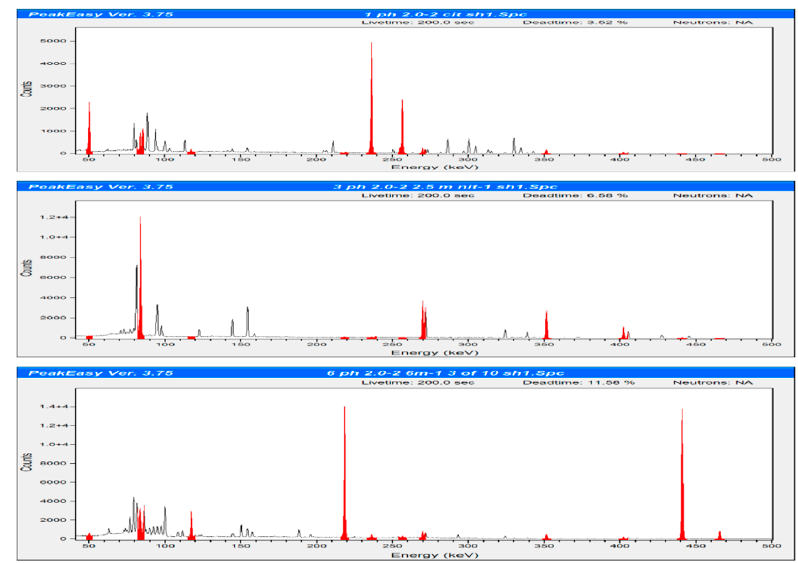
Figure 3. Gamma spectroscopy spectrums of the eluted: load ( top ), 2.5-M nitric acid ( middle ) and 6-M nitric acid ( bottom ) solutions from the cation study with 1 M citric acid at pH 2.0. PeakEasy version 3.75 was used to plot the spectra from 40.9 to 500.5 keV, and the following regions of interest were highlighted: 227 Th and daughters 50 keV ( 227 Th), 83 keV ( 223 Ra), 118 keV ( 209 Tl), 218 keV ( 221 Fr), 236 keV ( 227 Th), 256 keV ( 227 Th), 269 keV ( 223 Ra), 271 ( 229 Rn), 351 keV ( 211 Bi), 402 keV ( 219 Rn), 440 keV ( 213 Bi) and 465 keV ( 209 Tl). Table 1. Percentage of eluted elements in the various steps of the separation using the following rinse sequence: 5 mL of 1 M citric acid pH 2, 3 mL of water, 3 mL of 2 M nitric acid, 2 × 3 mL of 2.5 M nitric acid and 2 × 10 mL of 6 M nitric acid. Volume of Ag50 × 8 1 mL. Bolded values are the highest value for the elution of the element, and empty boxes represent samples that were <1% or not detected. NM: not measured.